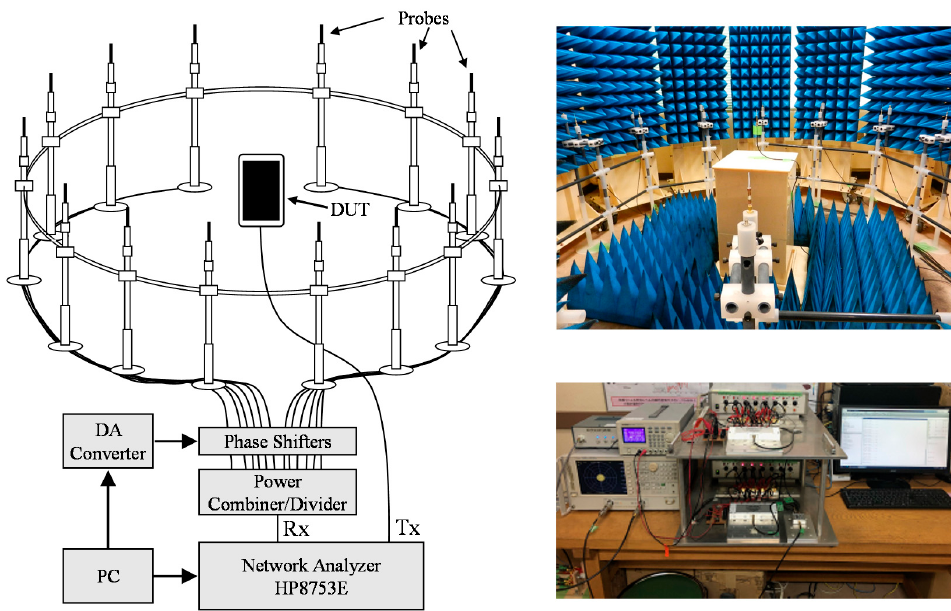
Figure 13. Two-dimensional bidirectional MIMO-OTA apparatus.